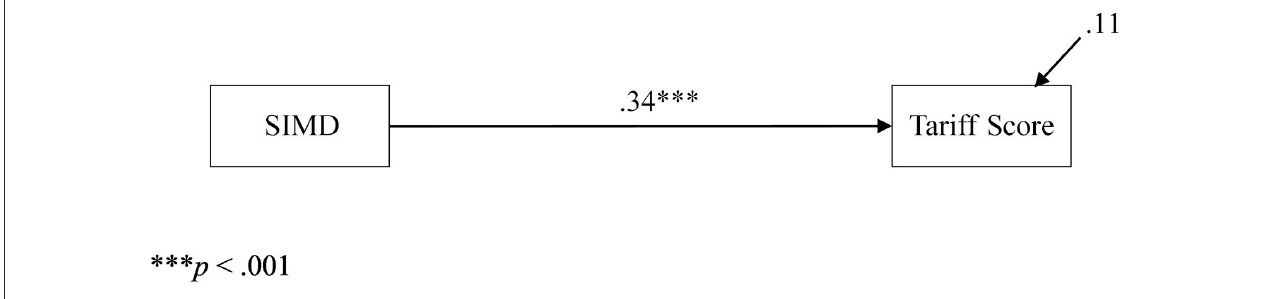
FIGURE 1 | Path model from SIMD to grade with standardized estimates.